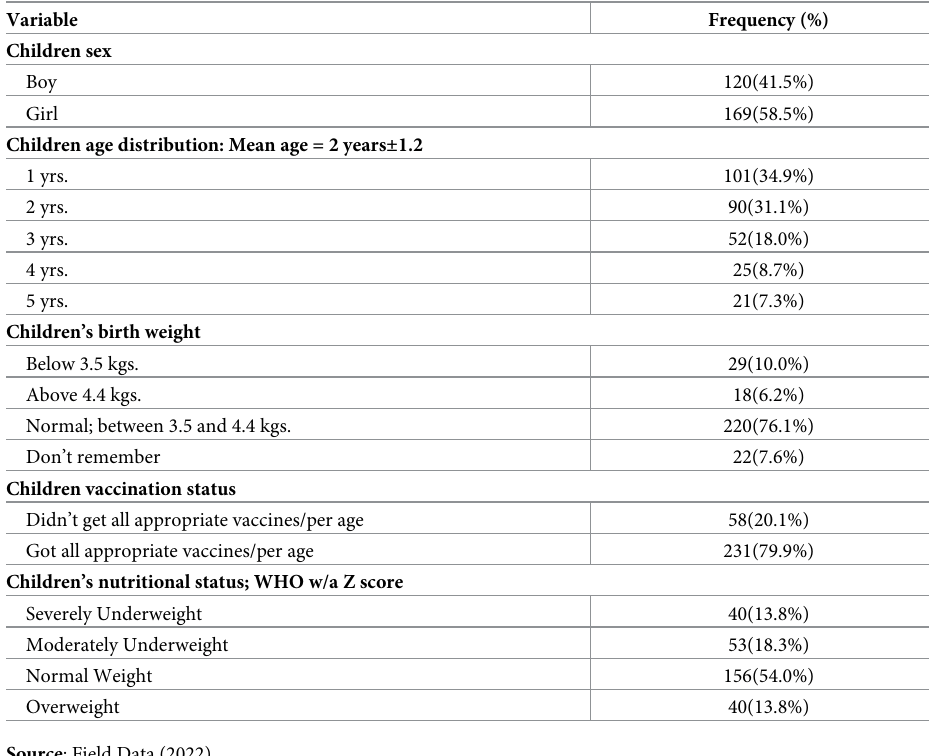
Table 2. Socio-demographic characteristics profiles of caregivers’ children (n = 289).